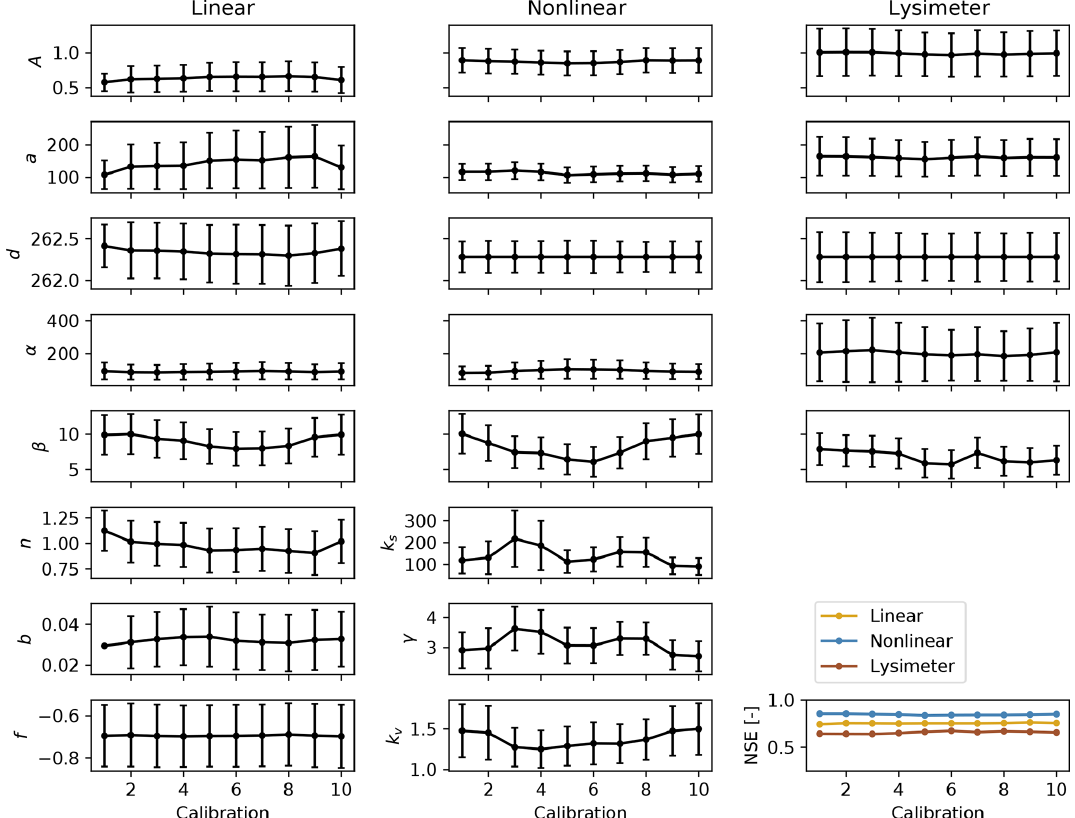
Figure A3. Parameter values and their 95% confidence interval for the three models calibrated on 10 time series. Note that when possible, the y axis is shared between the different columns for comparison purposes. The bottom right subplot shows the model performance for each calibration, measured as the NSE between the observed and simulated groundwater levels.